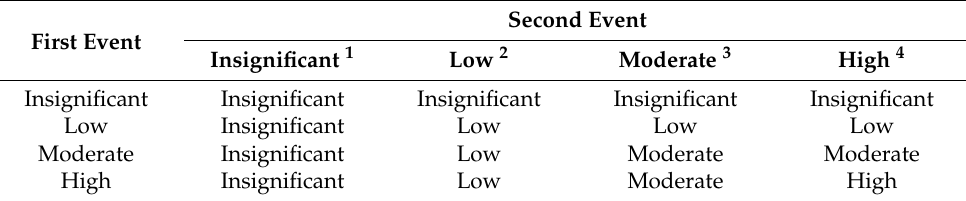
Table 1. Combination matrix generated to unify the conditional risk estimates, which include factors that assume that the second event (i.e., node) is totally conditional on the previous event (first event).